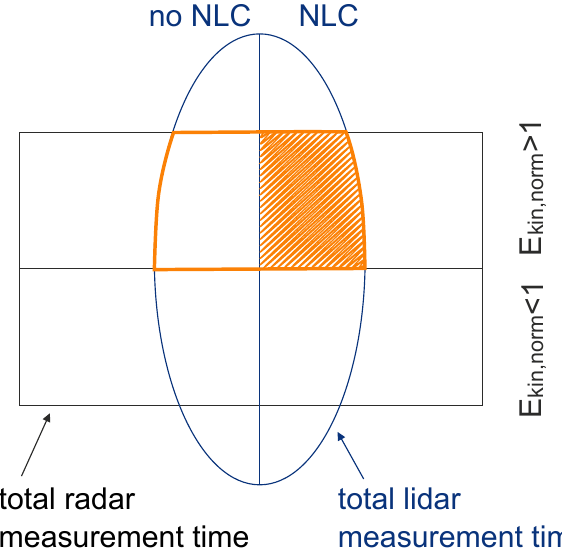
Fig. 4. Schematic visualization of the available lidar and radar Figure 4 schematically visualizes the calculation of η . The data. From the radar data times of high and low gravity wave ac- rectangle depicts all points in time where wind measurements tivity in a certain period range are identified ( E kin , norm > 1 and E kin , norm < 1 respectively) and from the lidar data times of NLC are available, respectively the oval all points in time where detection. The NLC occurrence rate during high gravity wave ac- lidar measurements were performed. In our analysis we in- tivity is the fraction of the orange shaded area with respect to the clude all points in the overlapping area (not to size). The data orange framed points are then further sorted according to the normalized ki- netic energy (upper and lower part of the rectangle) and ac- cording to whether NLC were detected or not (right and left part of oval). The NLC occurrence rate at enhanced gravity wave activity is then the fraction of the orange shaded area to the total orange framed area, or in terms of measurement time T NLC given E kin , norm > 1. For low gravity wave T NLC + T noNLC